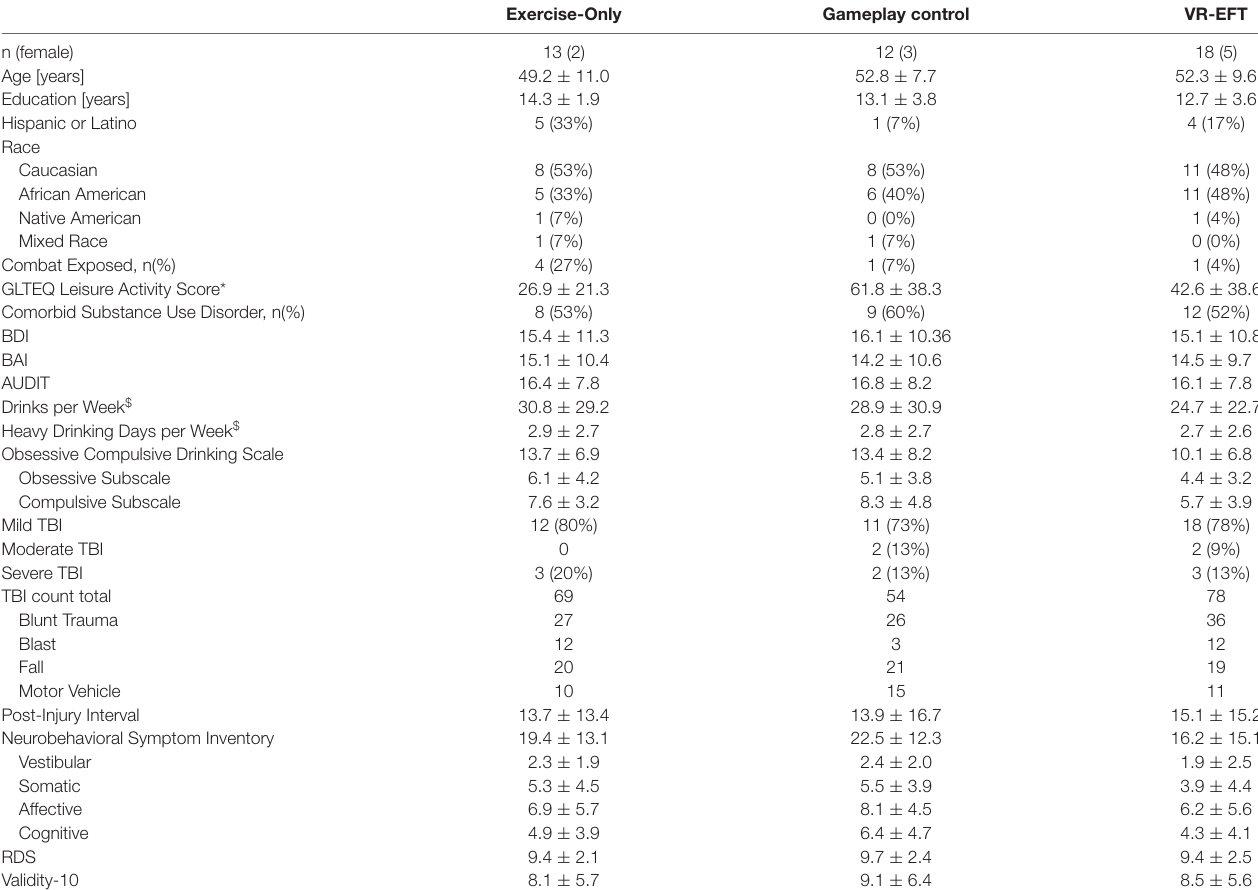
TABLE 1 | Participant characteristics (Means ± Standard